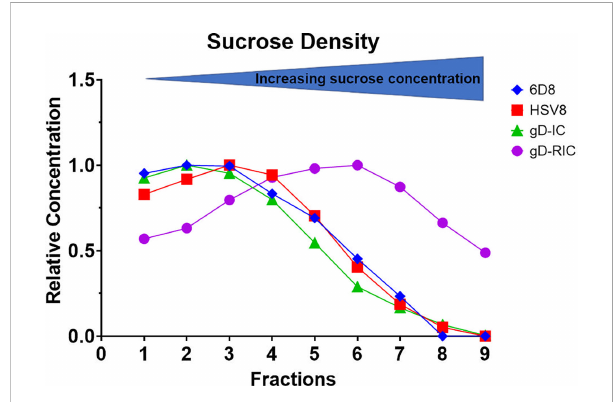
FIGURE 3 Sucrose gradient density pro fi le of gD-IC and gD-RIC. Using HSV8 and 6D8 mAbs as controls, gD-IC and gD-RIC were separated by sucrose gradient sedimentation using 5/10/15/20/25% discontinuous sucrose layers. The protein concentration of each fraction was analyzed by spectrophotometry and representative results from three independent experiments are shown; direction of sedimentation is left to right. The peak concentration was arbitrarily assigned a value of 1.